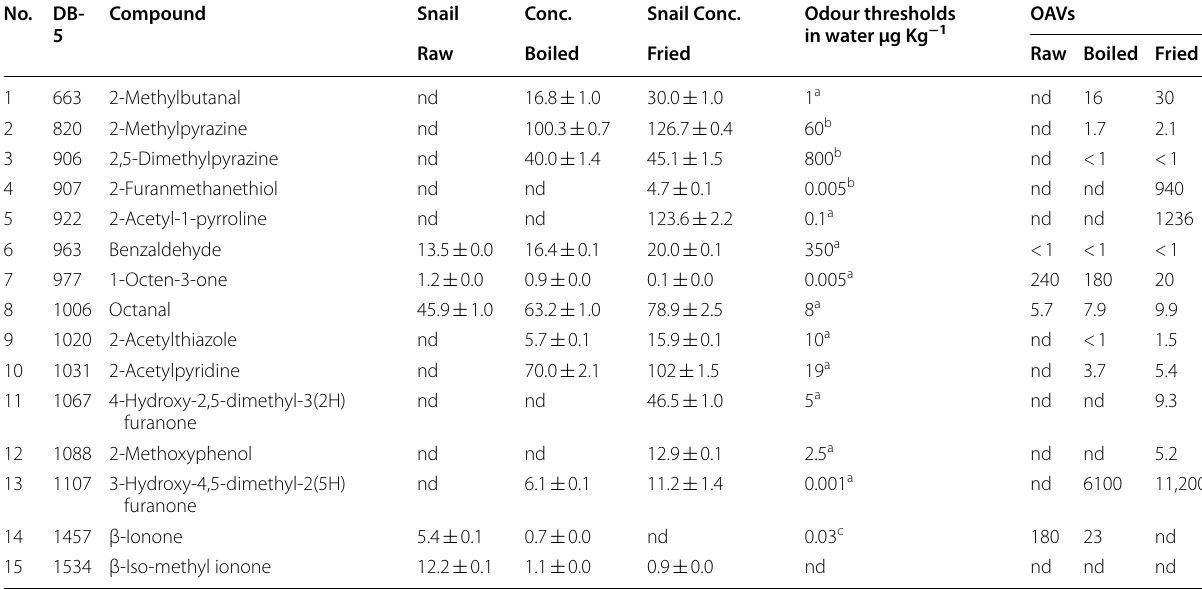
Table 3 Concentrations (µg Kg − 1 fresh weight) and odour activity values (OAVs) of aroma-active odorants (FD boiled and fried giant snail ( A. fulica